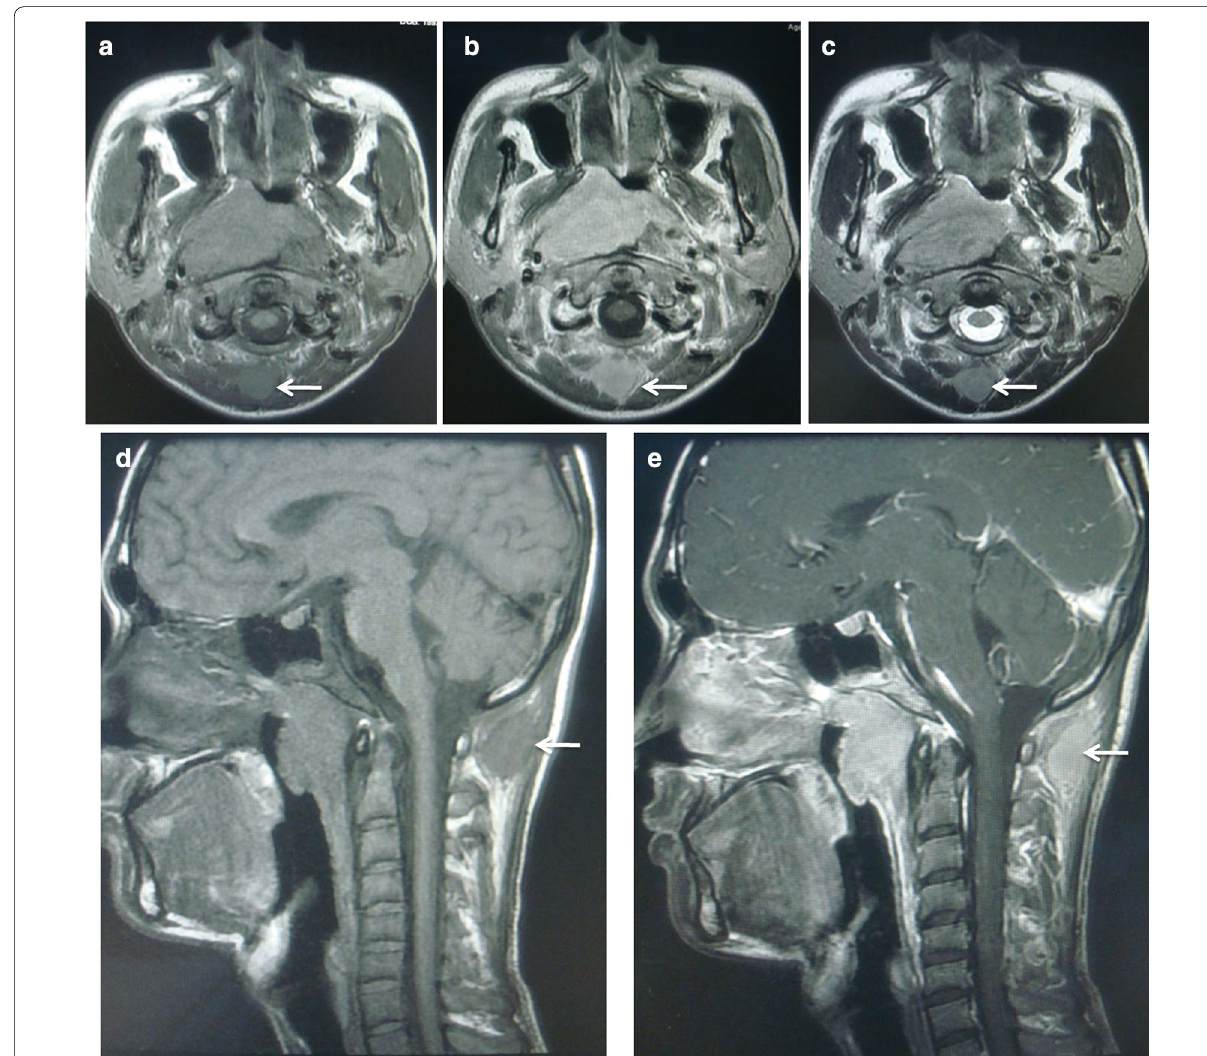
Fig. 2 Magnetic resonance (MR) imaging of the NPC patient before treatment. T1‑weighted axial MR images a without contrast, b with contrast, and c T2‑weighted axial MR image show an occipital lymph node (18 mm 19 mm) with equal T1 signal, long or equal T2 signal, and obvious × enhancement ( arrows ). T1‑weighted sagittal MR image d without contrast and e with contrast also show an enlarged lymph node with enhance‑ ment in subcutaneous tissue of the occiput ( arrows